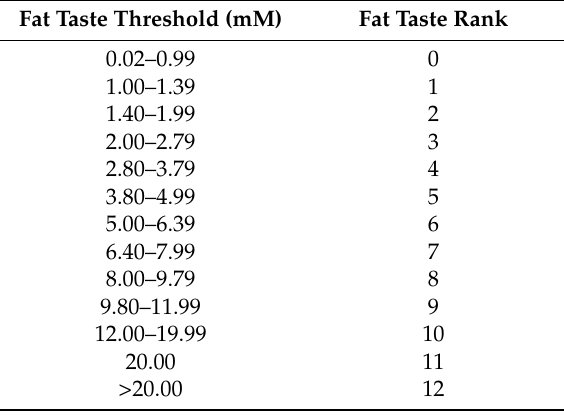
Table 1. Fat taste ranks and their corresponding fat taste threshold concentration ranges. Fat Taste Threshold